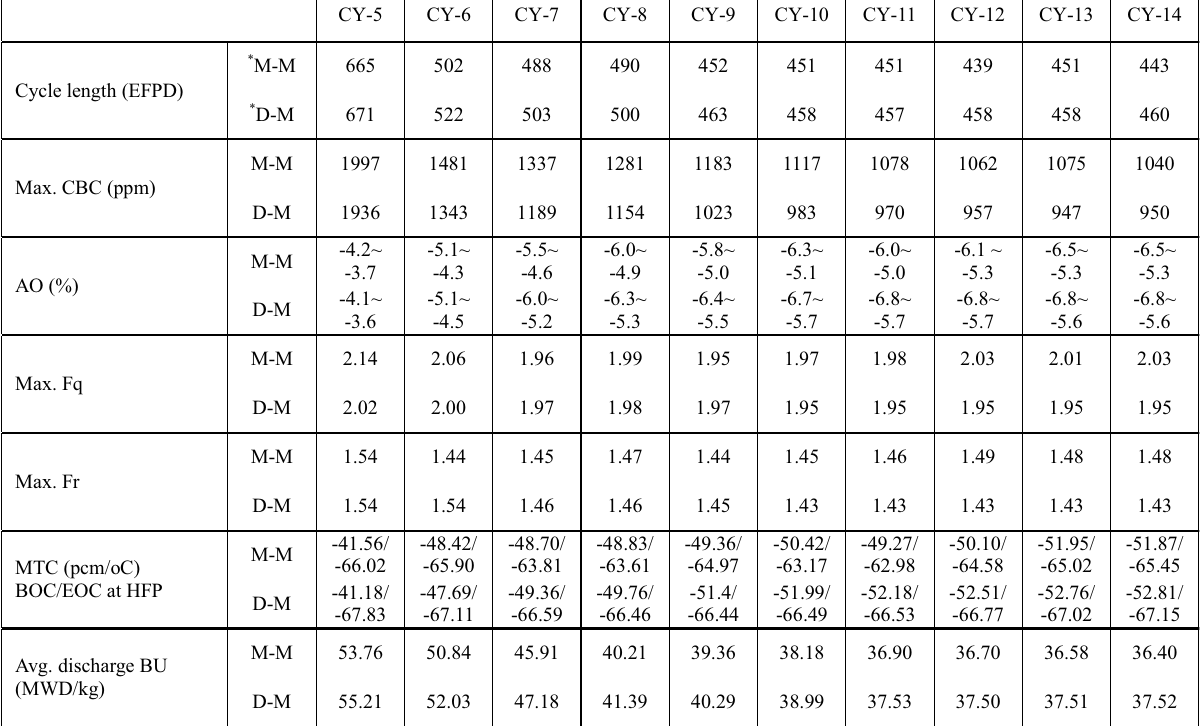
Figure 6. Comparison of cycle - wise critical boron concentration calculated by McCARD/MASTER Table III. Summary of neutronic characteristics from 5 th to 14 th cycles calculated by McCARD/MASTER and DeCART2D/MASTER two - step code